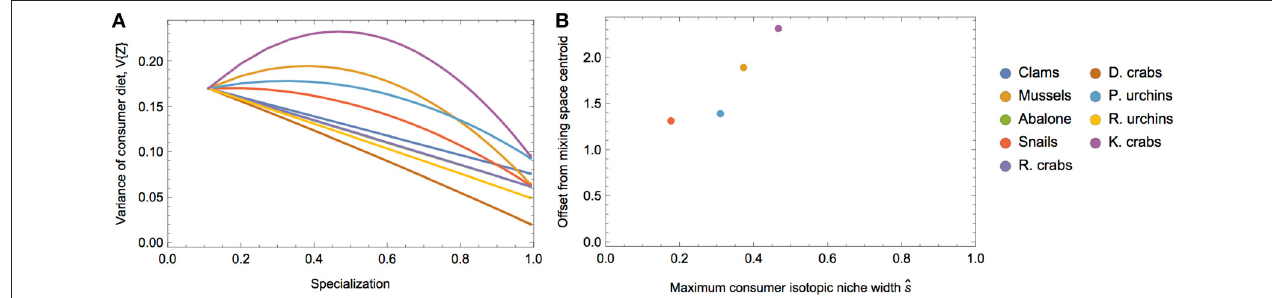
FIGURE 7 | (A) Predicted variance in δ 13 C of sea otter diets over different degrees of specialization on each prey in the system (colors). (B) Calculated maximum consumer niche width values as a function of specialization and the offset of the prey isotopic mean from the mixing space